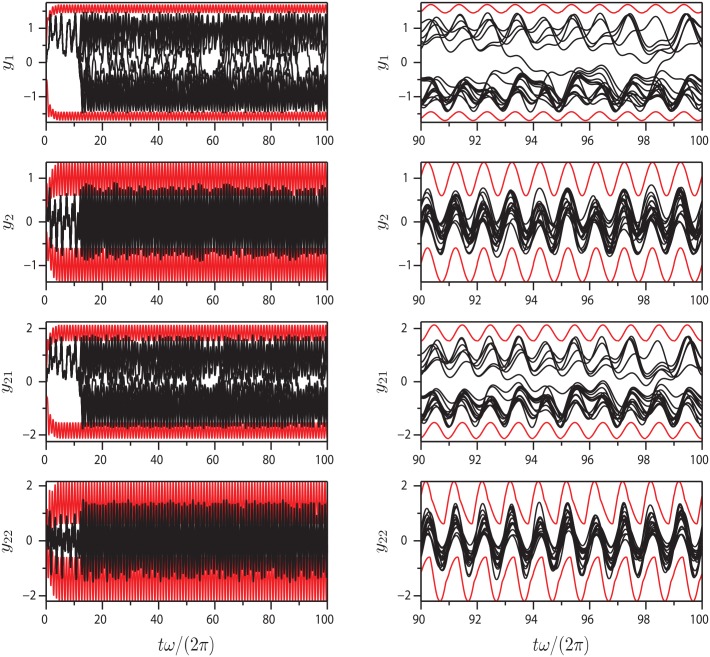
Extrema of Eq (12): Plots of extrema (red) and 20 different time series (black) of variables y1, y2, y21 and y22 for parameter set I.The bounds for odd (0th order) variables are somewhat tighter than those of even numbered (1st order) variables.